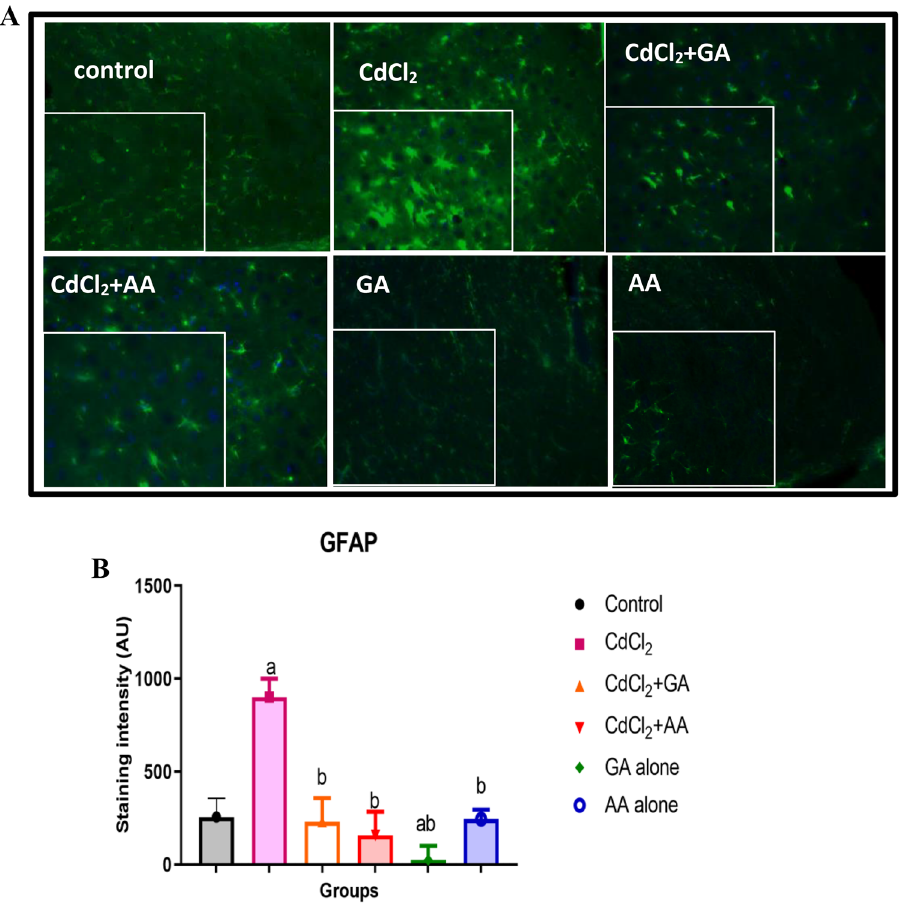
Figure 10. ( A ) Immunofluorescence showing Glial fibrillary astrocytic protein (GFAP) positive cells following the administration of CdCl 2 , GA and AA. ( B ) Quantification of mean astrocyte count. GA gallic acid, AA ascorbic acid scale bar = 50